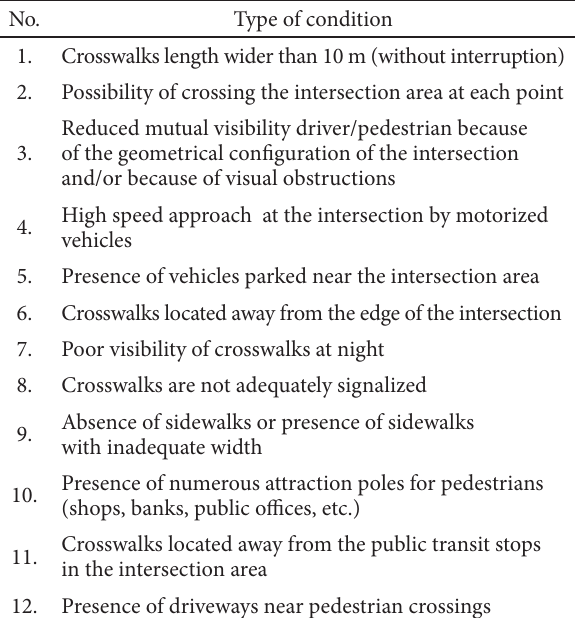
Table 1. The unsafe conditions for pedestrians in urban road intersections (Canale et al.